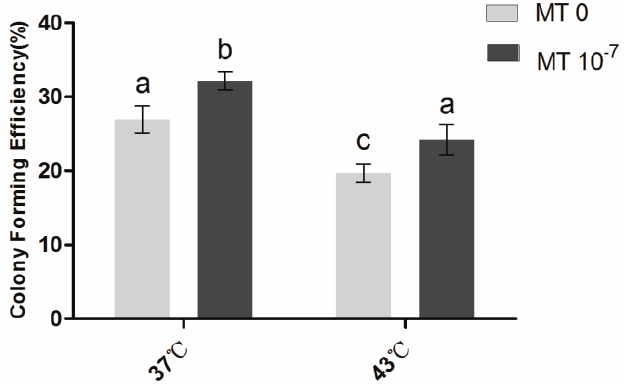
Figure 1. Effects of melatonin on the CFE of granulosa cells. MT: melatonin. Each bar represents the mean ± SEM for experiments performed in triplicate. Different letters indicate significant differences, p <